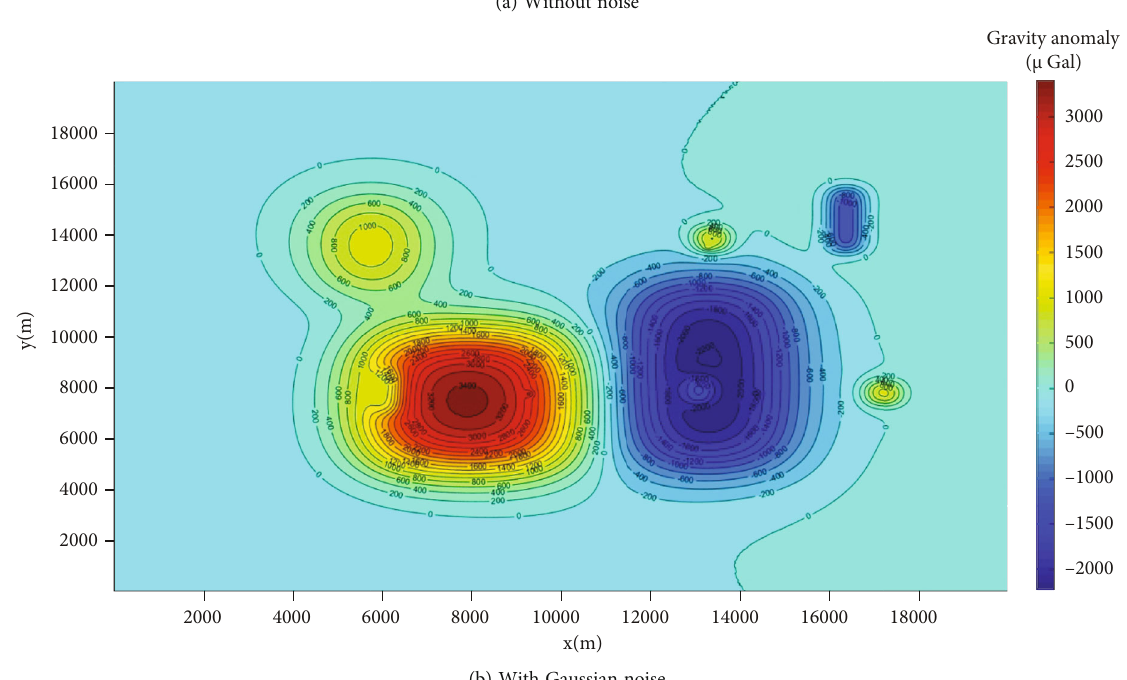
Figure 2: Gravity fi eld distribution of the forward